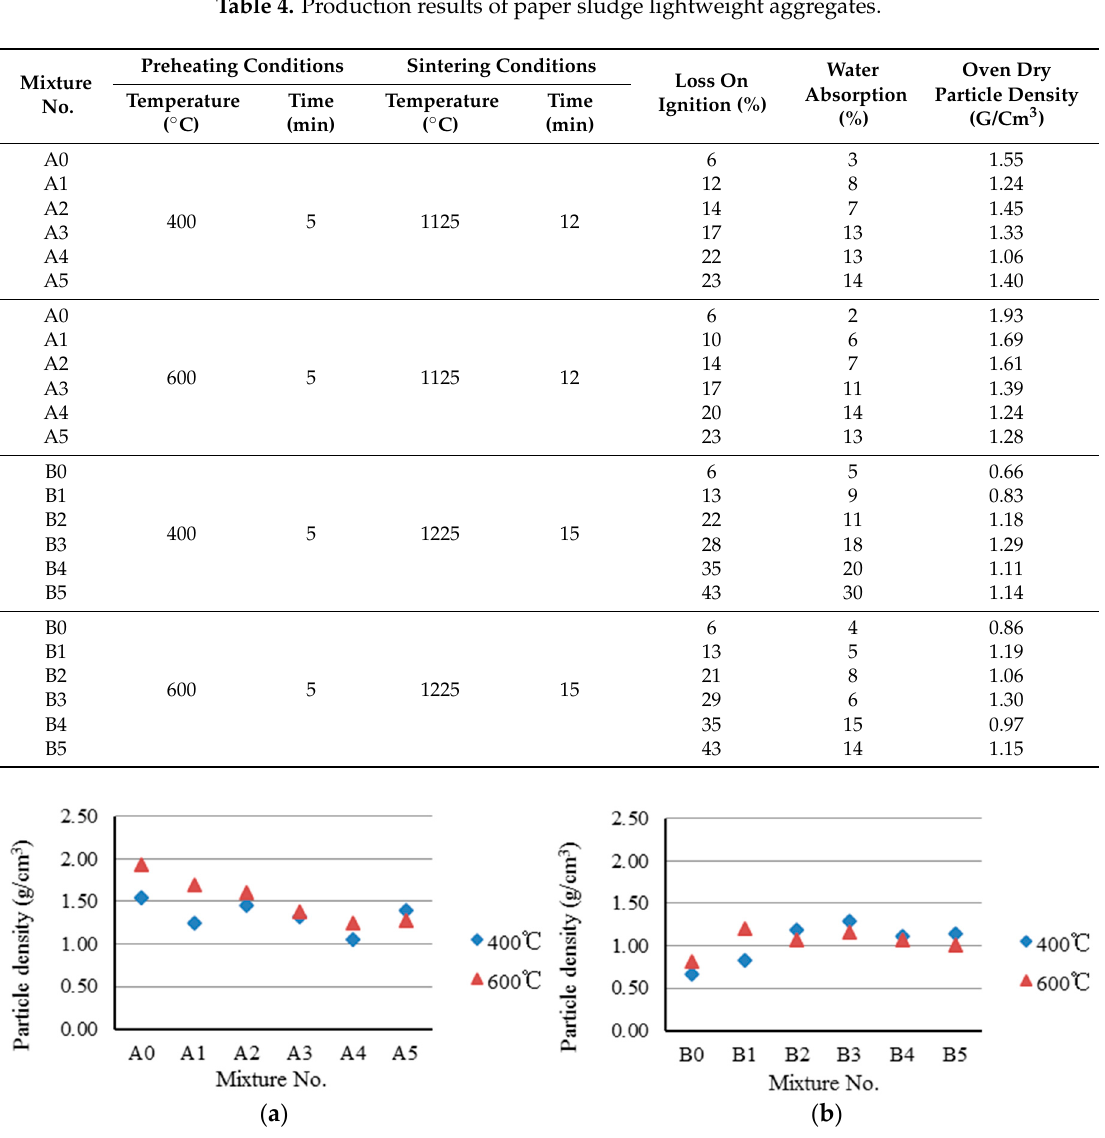
Figure 3. Particle density of paper sludge lightweight aggregates. ( a ) A series; ( b ) B series.